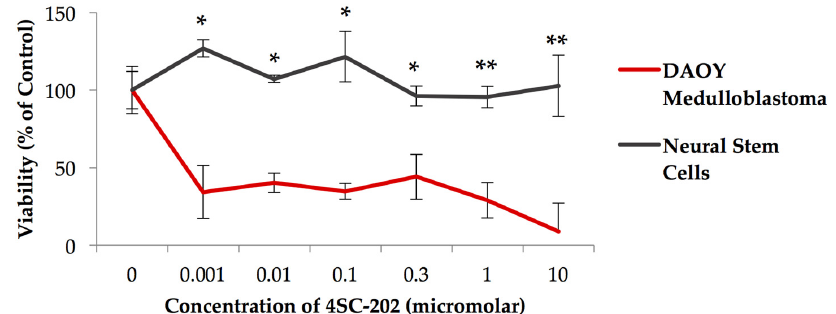
Figure 1. Exposure of DAOY medulloblastoma to 4SC-202 significantly reduces cell viability but does not affect the viability of control neural stem cells, with p value < 0.01 at concentrations ranging from 1–10 µM (**), and p value < 0.05 (*) at concentrations ranging from 0.001–1 µM. Viability was measured using Cell Titer Glo 2.0 (Promega).